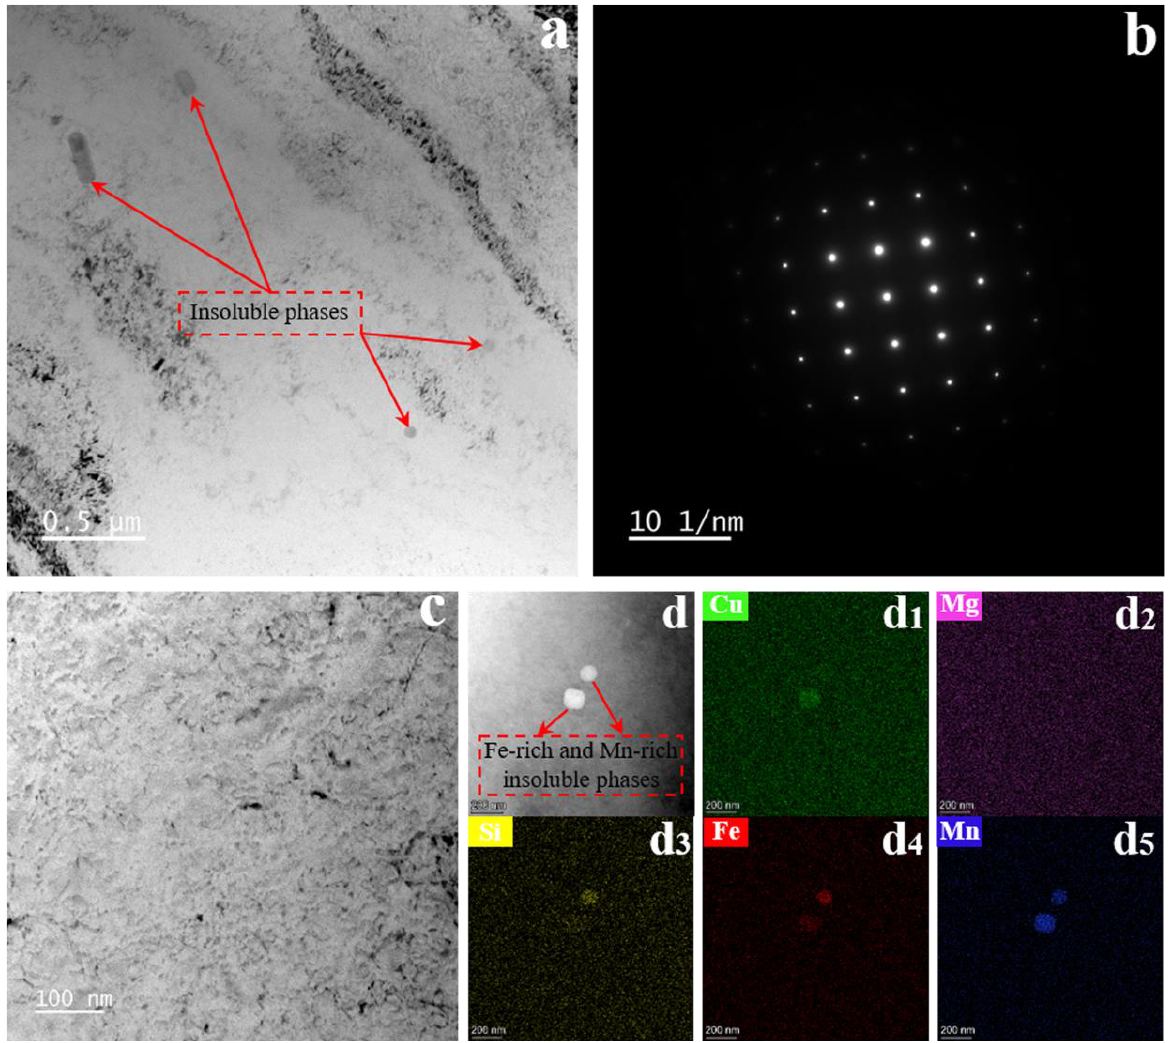
Figure 2. The solution treated without SMGT alloys. Low-magnification bright-field TEM image ( a ) and the corresponding selected area diffraction pattern ( b ), high-magnification bright-field TEM image ( c ), HAADF-STEM image ( d ), and the corresponding EDS elemental maps of copper ( d 1 ), magnesium ( d 2 ), silicon ( d 3 ), iron ( d 4 ), and manganese ( d 5 ).